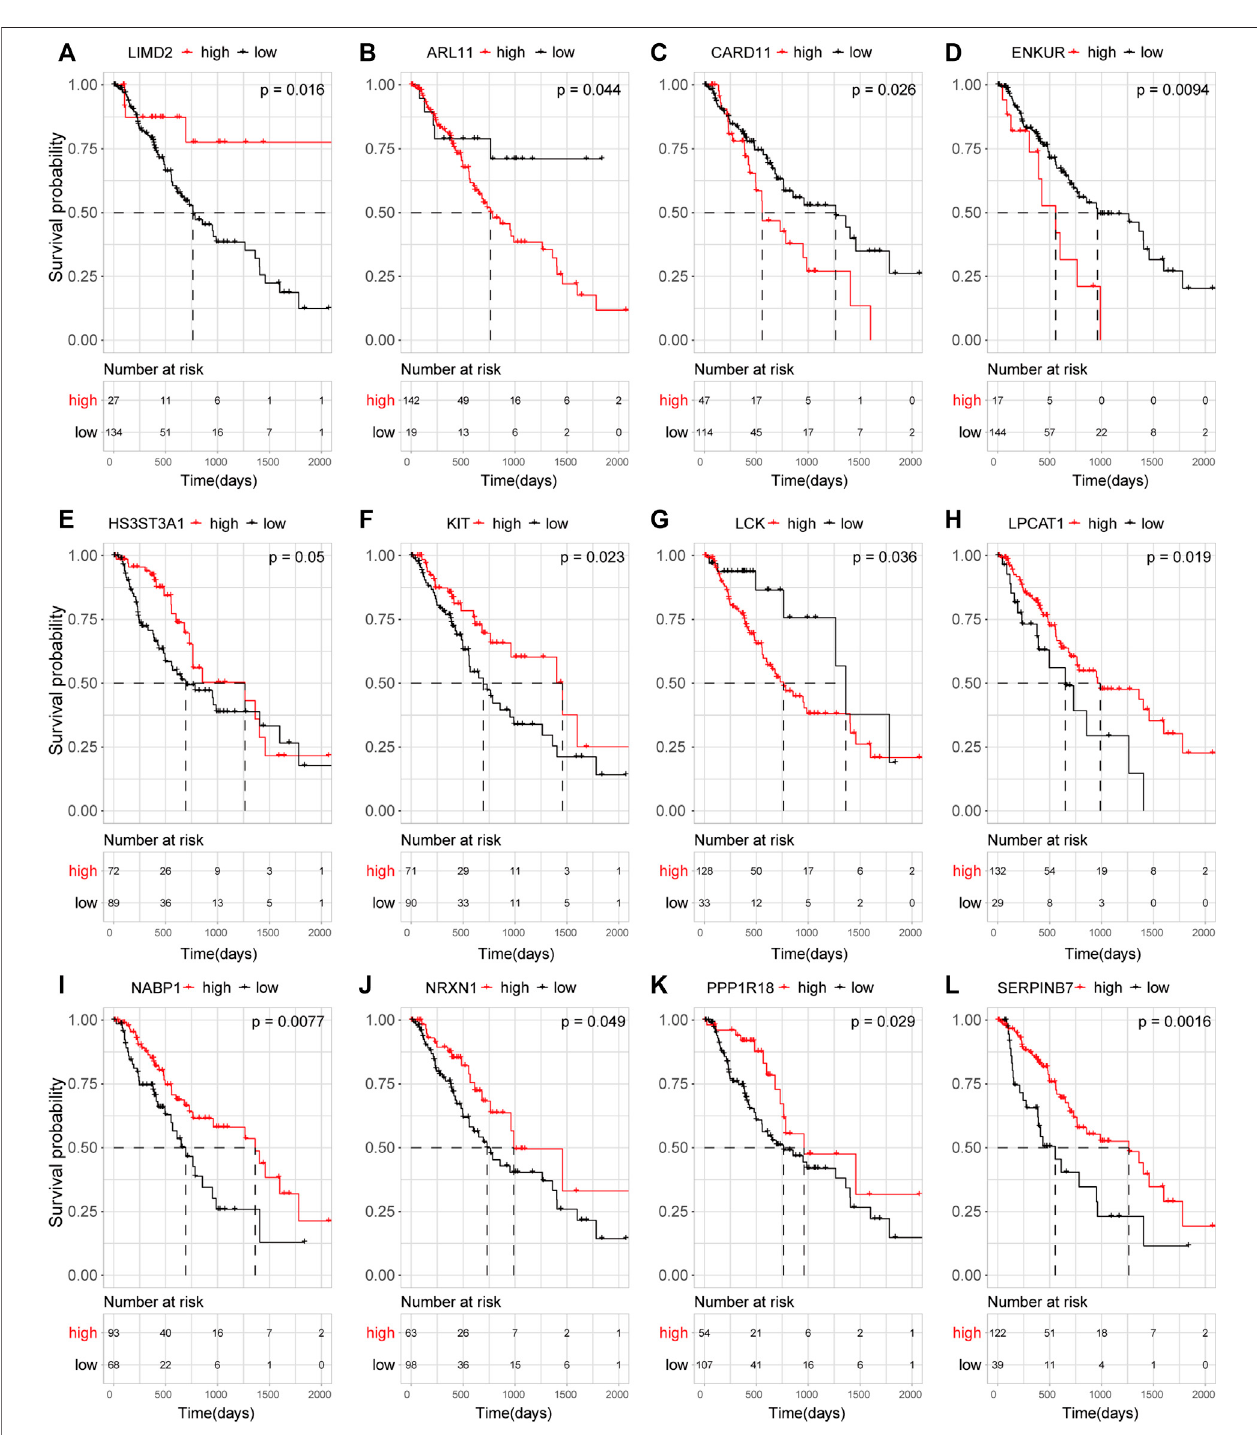
FIGURE 5 | Effect of target mRNA expression on the OS of ECA patients in TCGA database. Kaplan – Meier (KM) curves demonstrating the distinct outcomes of ECA patients. (A – L) KM curve of LIMD2 (A) , ARL11 (B) , CARD11 (C) , ENKUR (D) , HS3ST3A1 (E) , KIT (F) , LCK (G) , LPCAT1 (H) , NABP1 (I) , NRXN1 (J) , PPP1R18 (K) , and SERPINB7 (L)